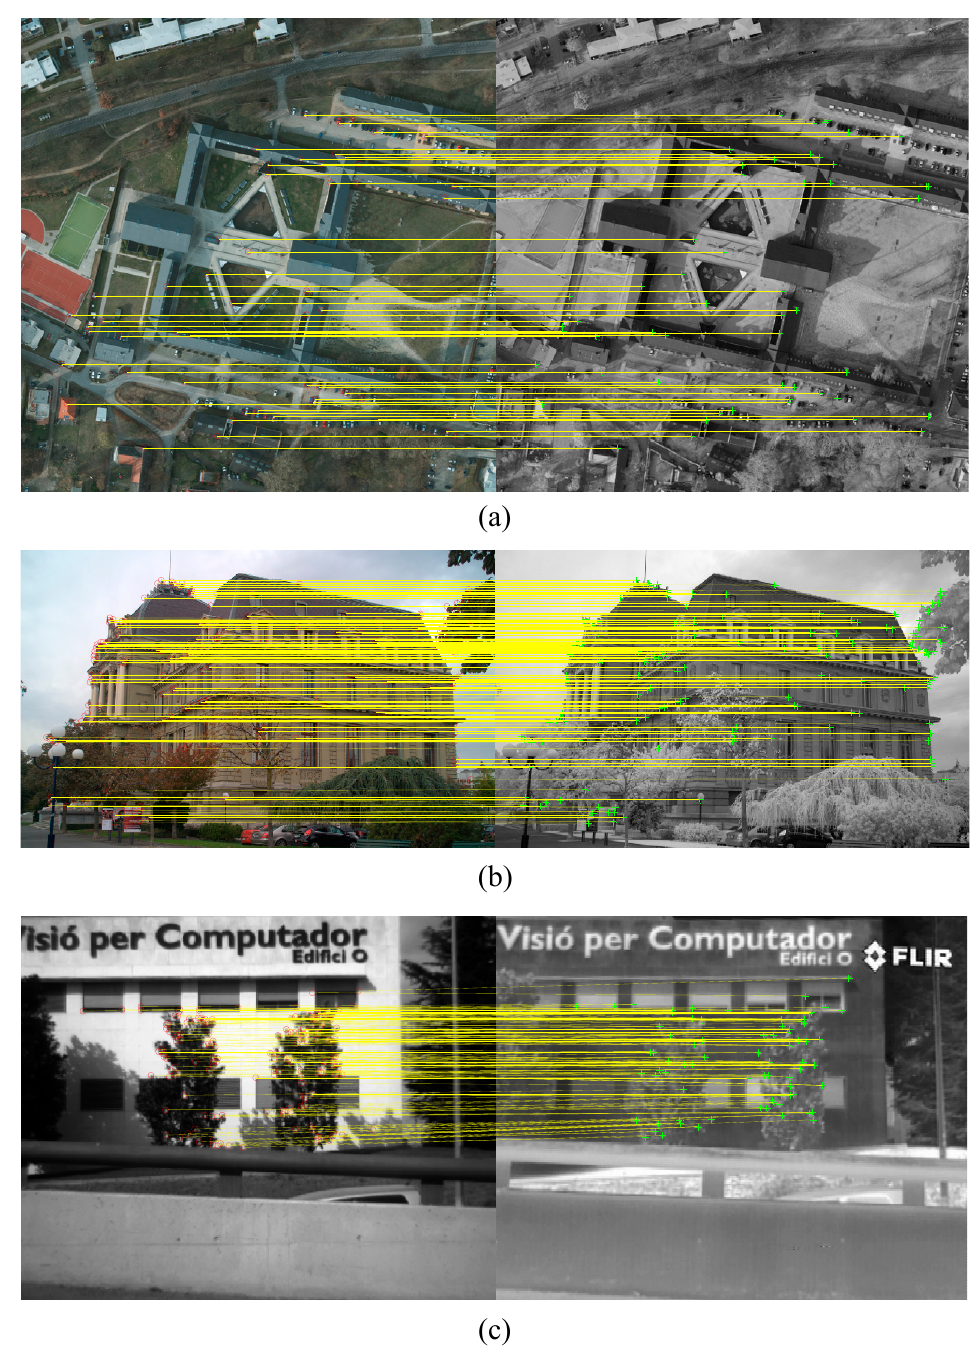
Figure 7. Sample one of feature matching results by the HOSM descriptor for the multispectral image pairs in three datasets. From top to bottom: matching results on ( a ) Potsdam dataset, ( b ) EPFL dataset, and ( c ) CVC dataset.